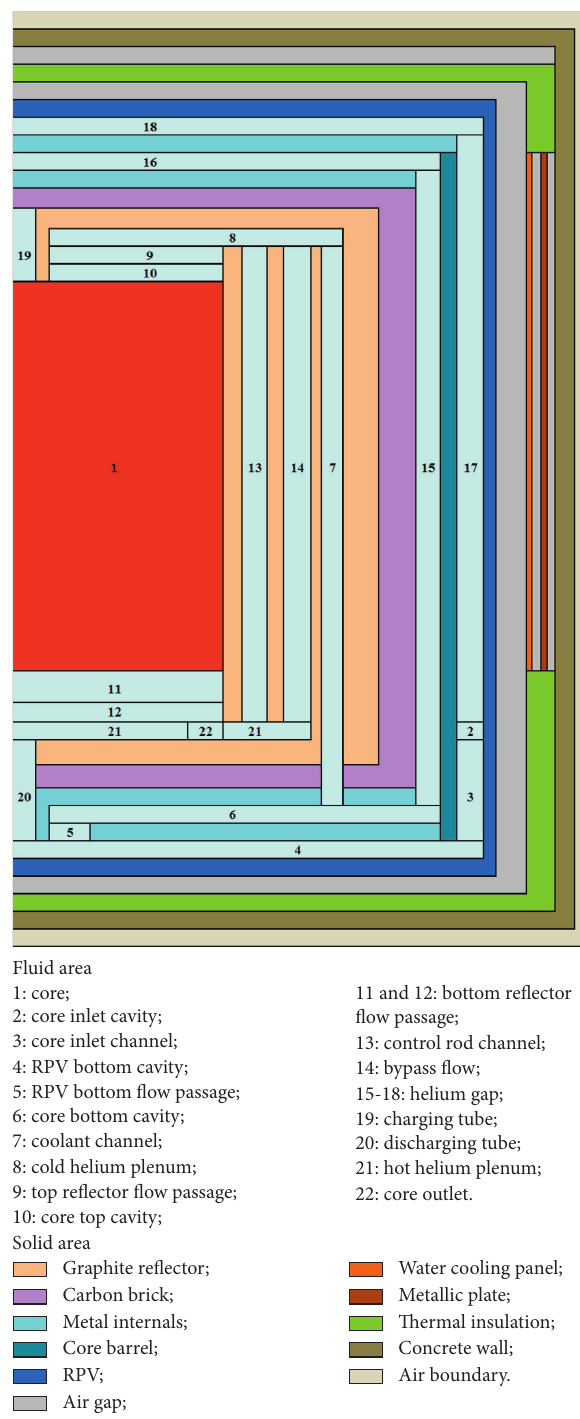
Figure 2: 2D TINTE model of the HTR-PM reactor in r-z